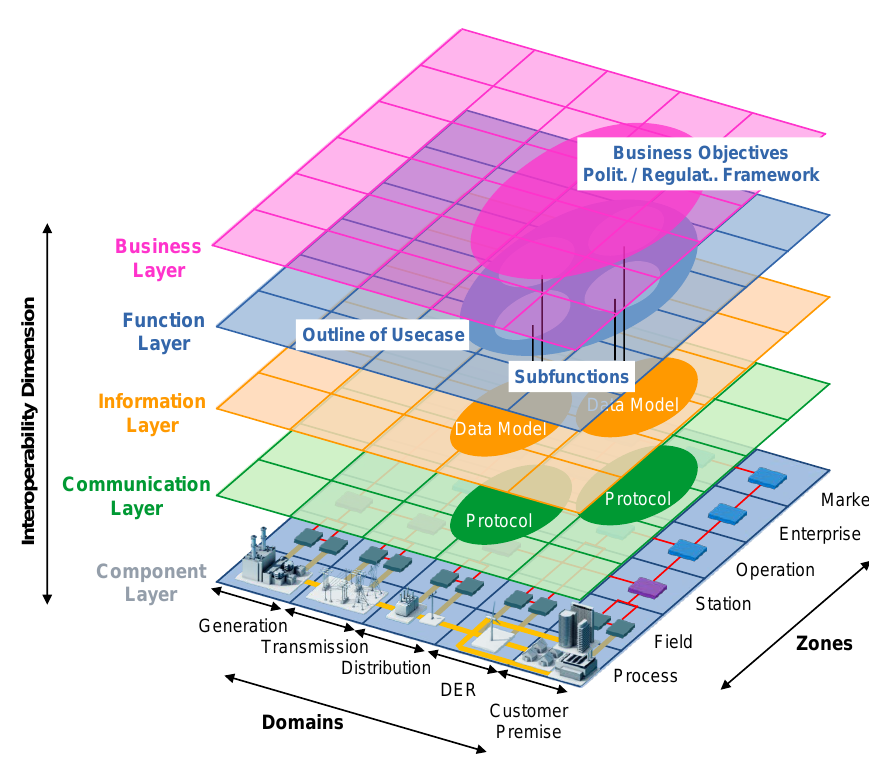
Figure 2. Overview of the Smart Grid Architecture Model (SGAM)